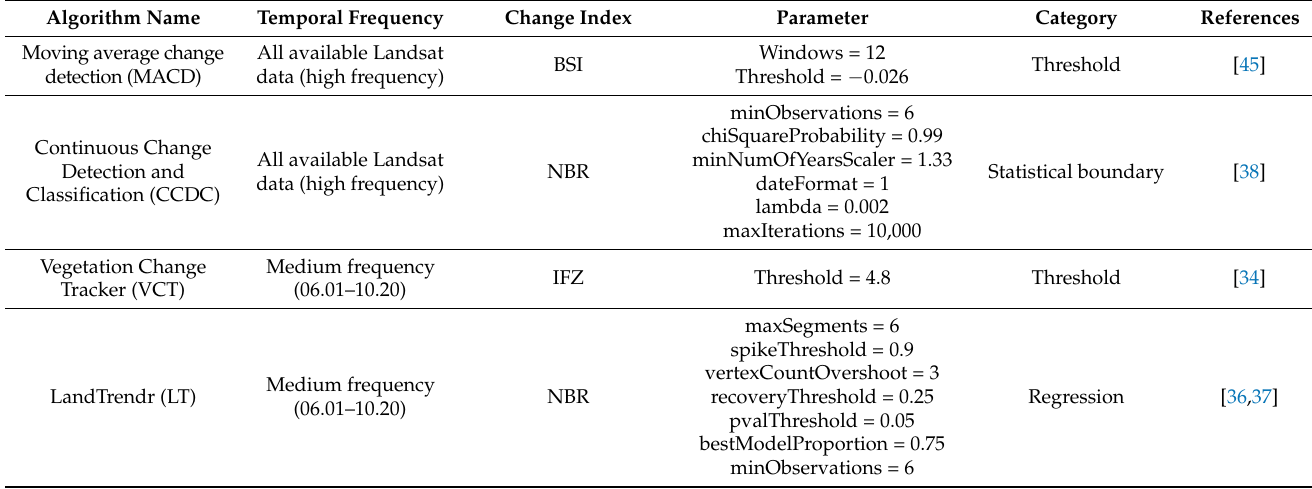
Table 2. Parameters of the four algorithms used in this